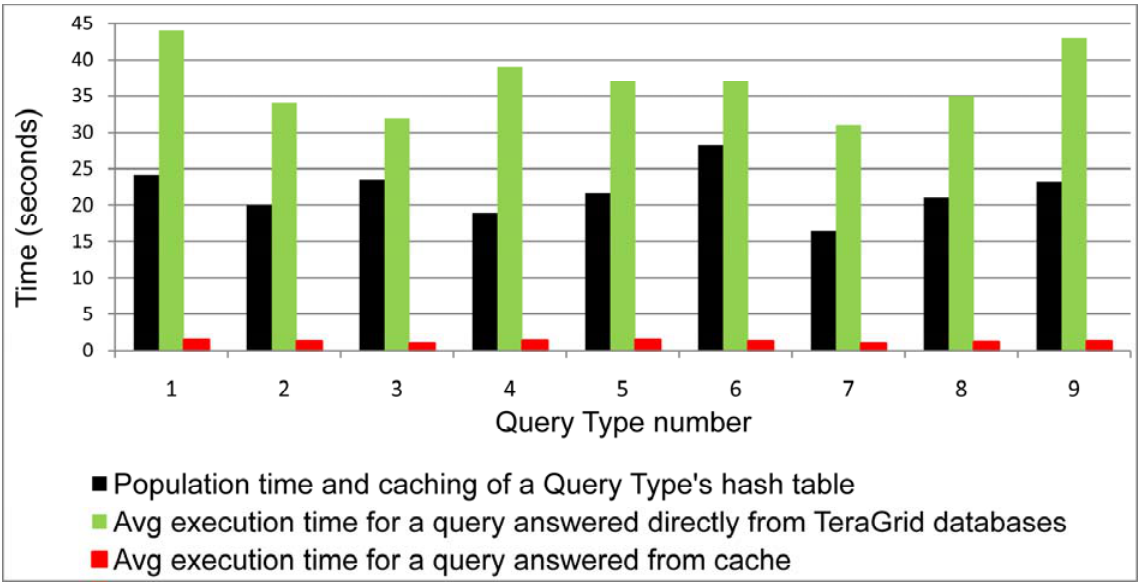
Fig. 7: Average query execution time and hash table population time per Query Type